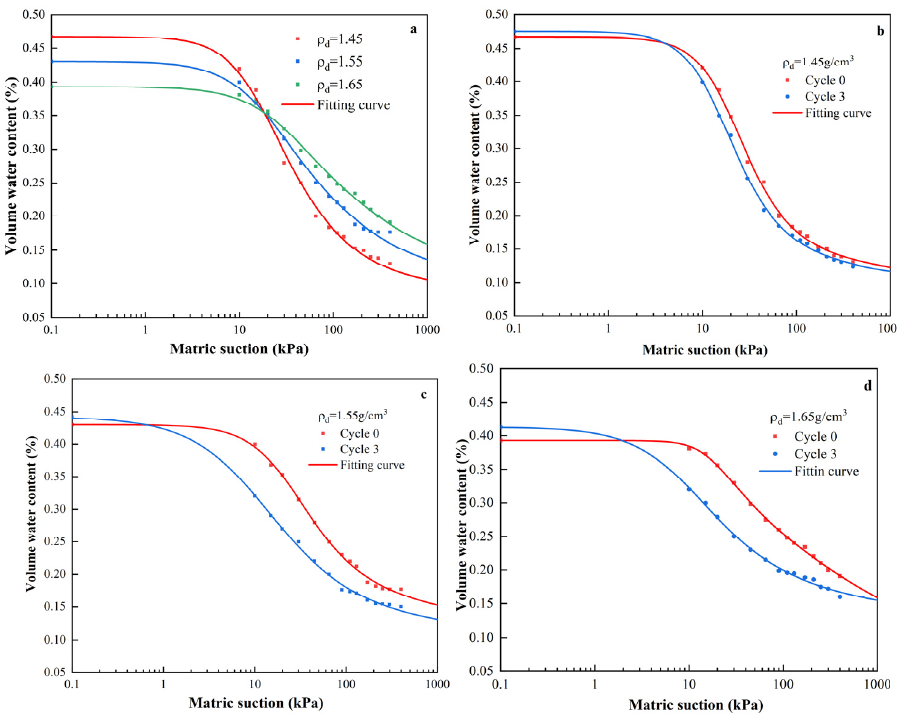
Figure 3. SWCC of compacted loess